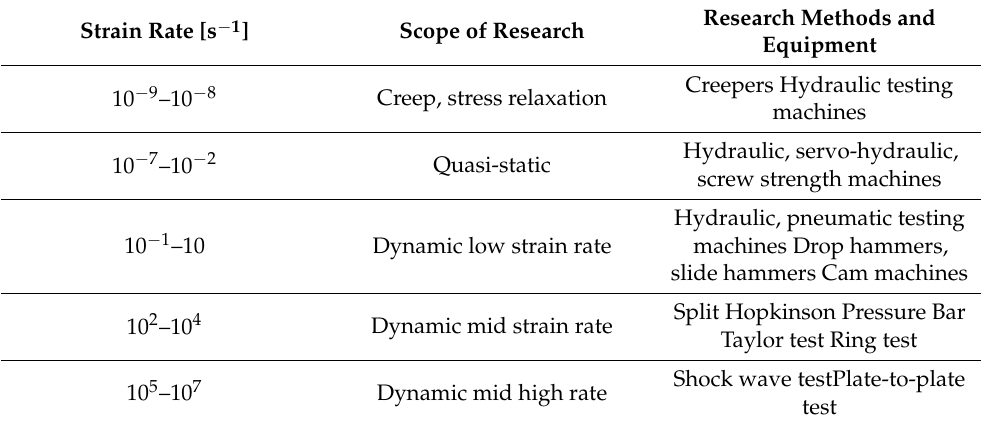
Table 2. Summary of research methods with the achieved strain rates